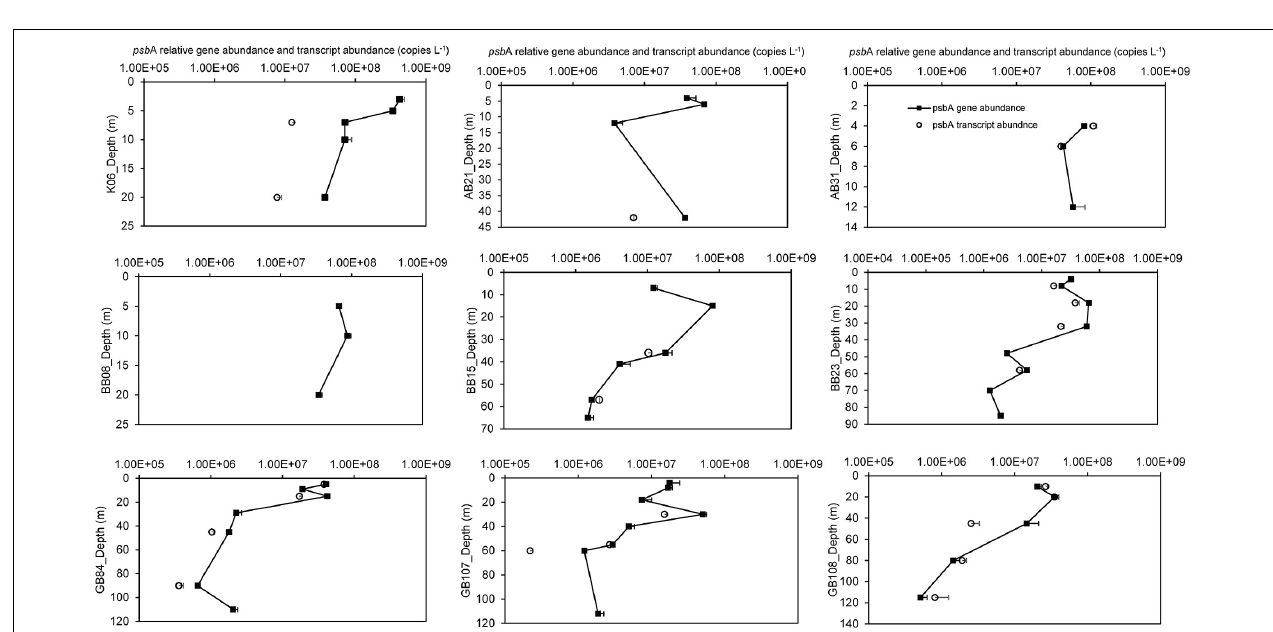
FIGURE 9 | Spatial distribution patterns of gene copy number (DNA) of the AP photosynthetic gene, puf M.